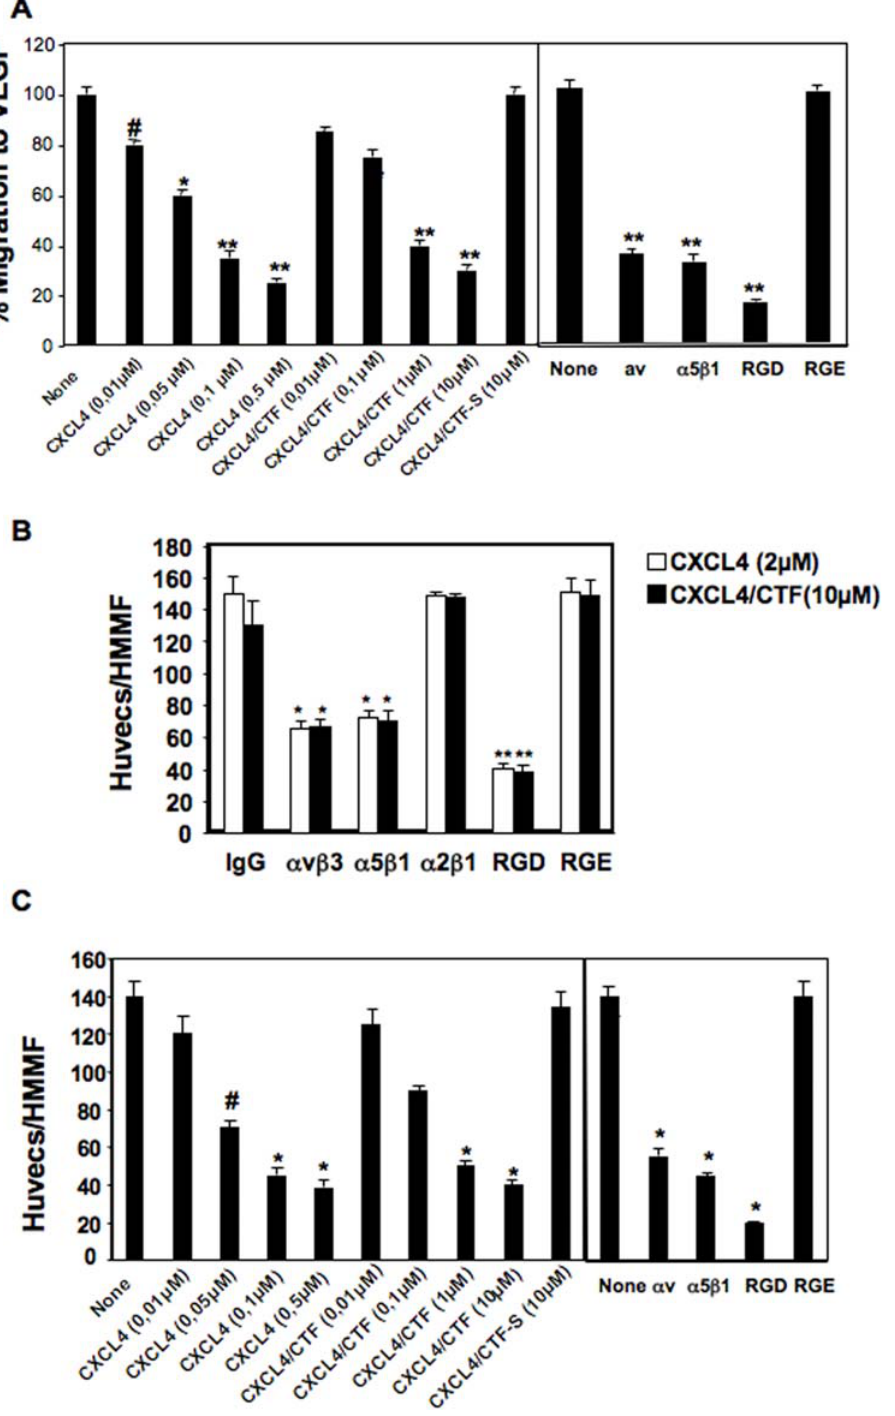
Figure 7. Immobilized CXCL4 or CXCL4/CTF promotes and soluble CXCL4 or CXCL4/CTF inhibits integrin-dependent endothelial cell migration. A. Soluble CXCL4 or CXCL4/CTF inhibits migration on fibronectin toward VEGF (5 ng/ml). HUVECs migration was determined in the presence or absence of the indicated concentrations of CXCL4 or CXCL4/CTF or CXCL4/CTF-S or 25 m g/ml of RGD-, RGE peptides or 10 m g/ml of anti- integrin antibodies (anti- a v; AV1 and anti- a 5 b 1; JBS5) as described in Material and Methods . Relative cell migration is indicated, each value is a mean 6 SEM from 3 independent experiments. Error bars represent the mean 6 SD, # , P # 0.05; *, P # 0.005, **, P # 0.001 compared to the number of cell migrated in the absence of CXCL4 or CXCL4/CTF or anti-integrin antibodies or RGD peptides. B. Immobilized CXCL4 or CXCL4/CTF supports HUVECs migration in a v b 3 and a 5 b 1 integrins-dependent manner. Cell migration assay was performed on immobilized CXCL4 or CXCL4/CTF in serum free medium and in the presence or absence of inhibitory anti-integrin antibodies or RGD-, RGE peptides. The results at each point are the mean cell number of 10 randomly selected high magnification microscopic fields. Error bars represent the mean 6 SD, *, P # 0.005; *, P # 0.001 compared to CXCL4 or CXCL4/CTF in the presence of IgG control antibody; n=3 independent experiments. C. Soluble CXCL4 or CXCL4/CTF inhibits migration on